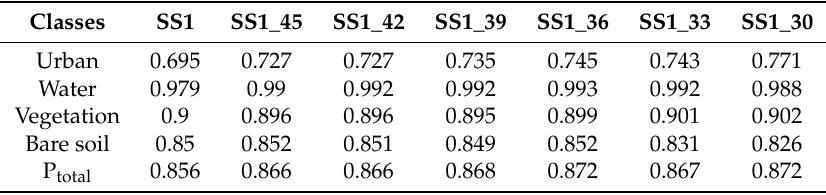
Table 25. Probabilities of correct classification depending on compressed image quality for Set 1, AGU coder, ML